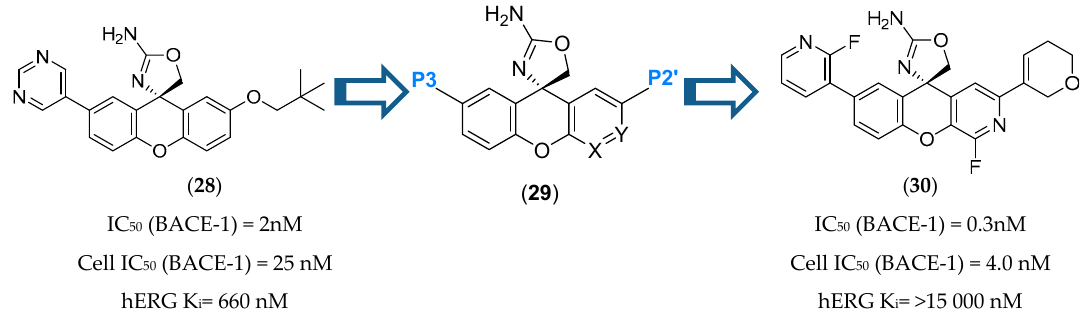
Figure 27. Spirocyclic aminooxazoline developed by Amgen [68,71].